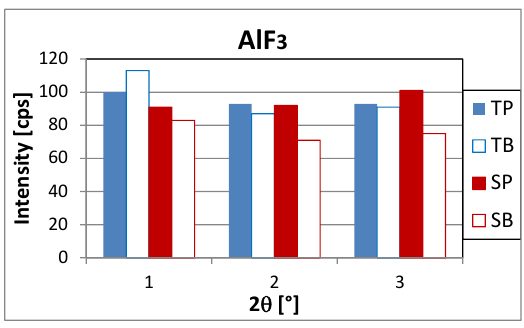
Figure 4. Distribution of the crystallized AlF 3 in the frozen bath samples, revealed by